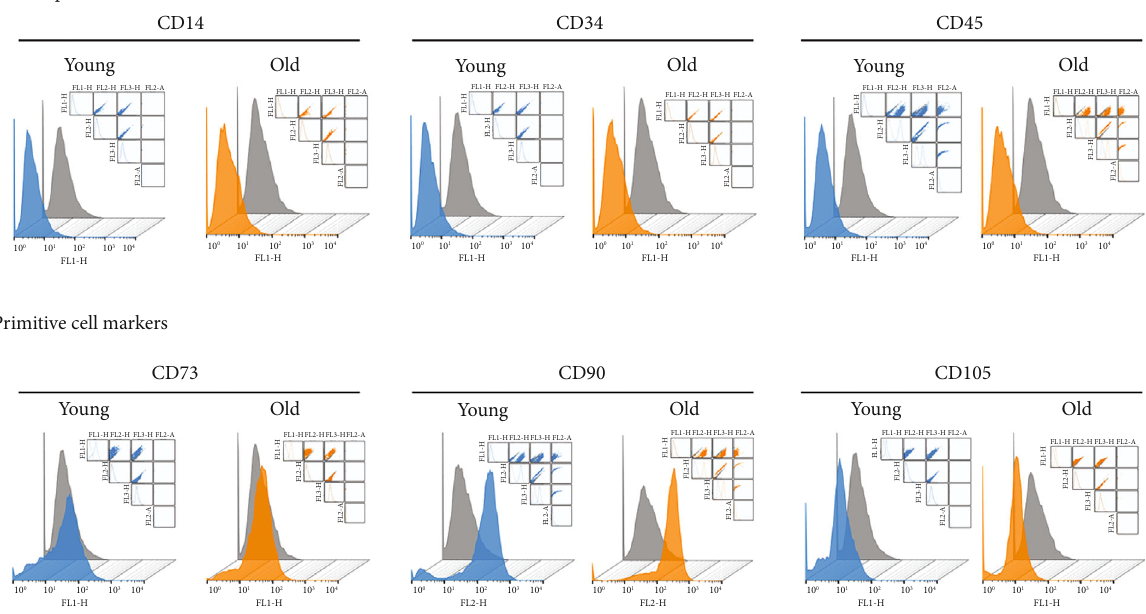
Figure 2: Changes in the expression of stem cell surface markers in TMSCs with serial passaging. Surface markers of TMSCs were characterized using FACS analysis. Both hematopoietic (CD14, CD34, and CD45) and primitive (CD73, CD90, and CD105) cell surface markers were examined. Young and old TMSCs were marked as blue and orange peaks,